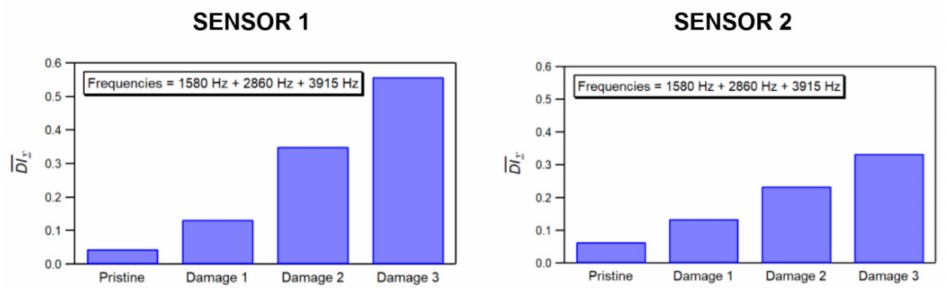
Figure 9. Pulse excitation: values of the damage index DI Σ calculated as the average of the DI S for the 1580, 2860 and 3915 Hz spectral frequencies at increasing damage